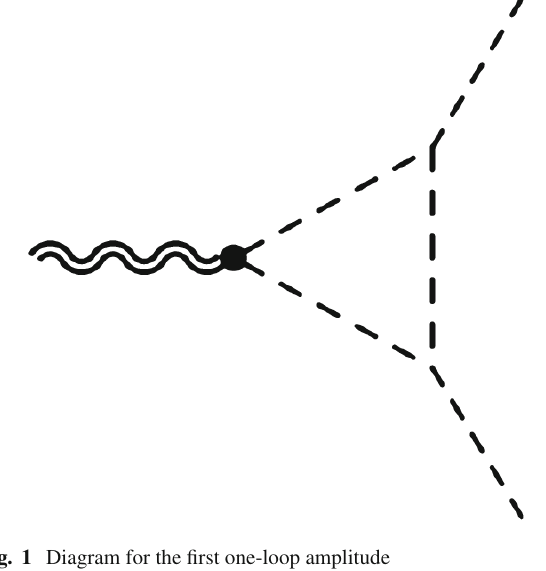
Fig. 1 Diagram for the first one-loop amplitude